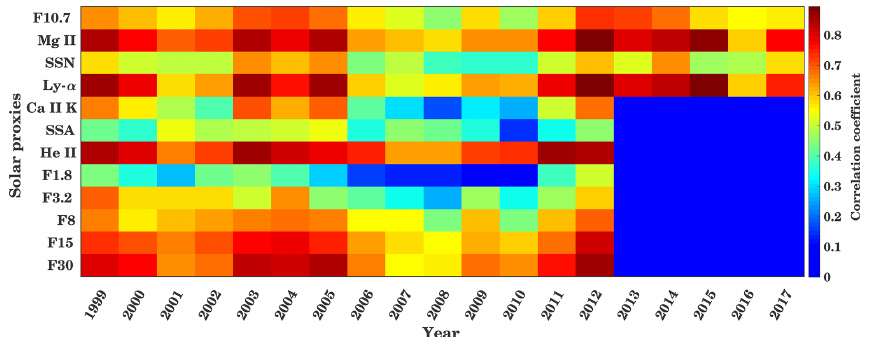
Figure A2. Correlation coefficient between GTEC and different solar proxies for the years 1999 to 2017 at the timescale of 16 to 32d at lag